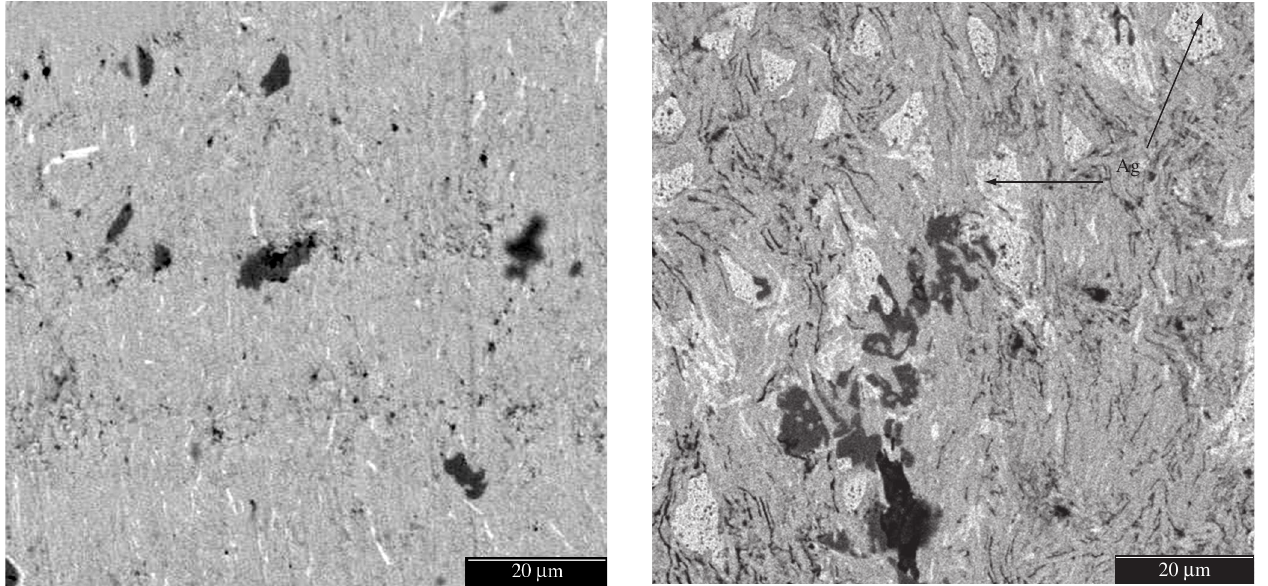
Figure 4. SEM images of the sintered blocks with 0 wt. (%) Ag (left) and 10 wt. (%) Ag (right). For both samples, the EDS analysis indicated: a matrix with a 2223 composition; Ca CuO and CuO (dark gray secondary phases). Silver particles can be seen in the 10 wt. (%) Ag sample (light gray 2 3